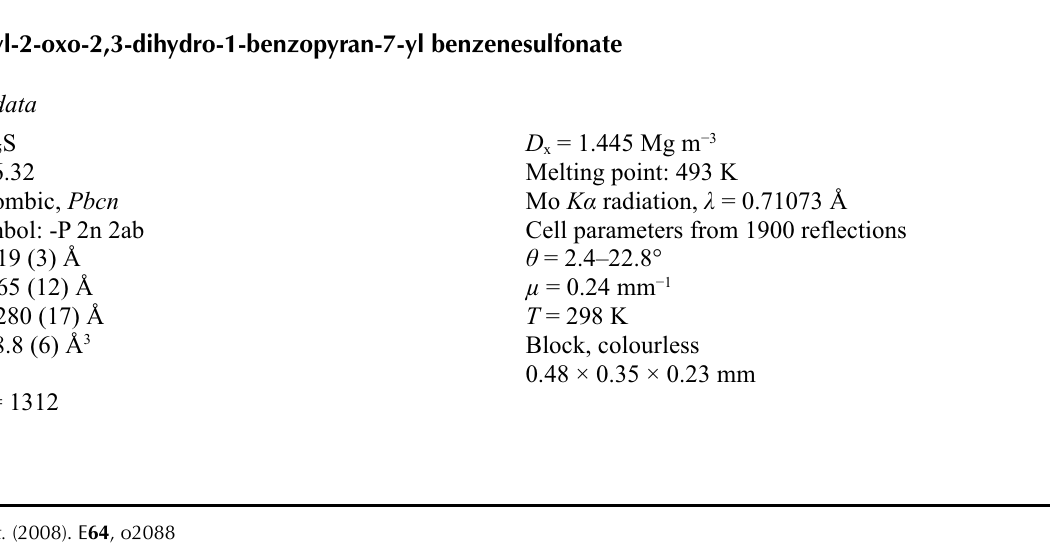
The crystal structure of the title compound, showing the formation of a hydrogen-bonded R 33 (18) ribbon along [010]. For clarity, H atoms not involving in H-bonding have been omitted. Dashed lines indicate hydrogen bonds [Symmetry codes: (*) 1/2 - x , 1/2 + y , z ; (#) 1/2 - x , -1/2 + y , z ; (&) x , 1 + y , x ; ($) x , -1 + y , z